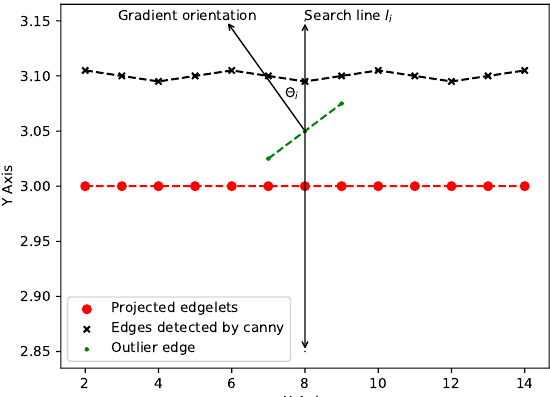
Figure 13. Challenges due to outlier edges, such as those due to image noise and edges arising from features that do not belong to the inspection element, when searching for an image edge corresponding to the projected